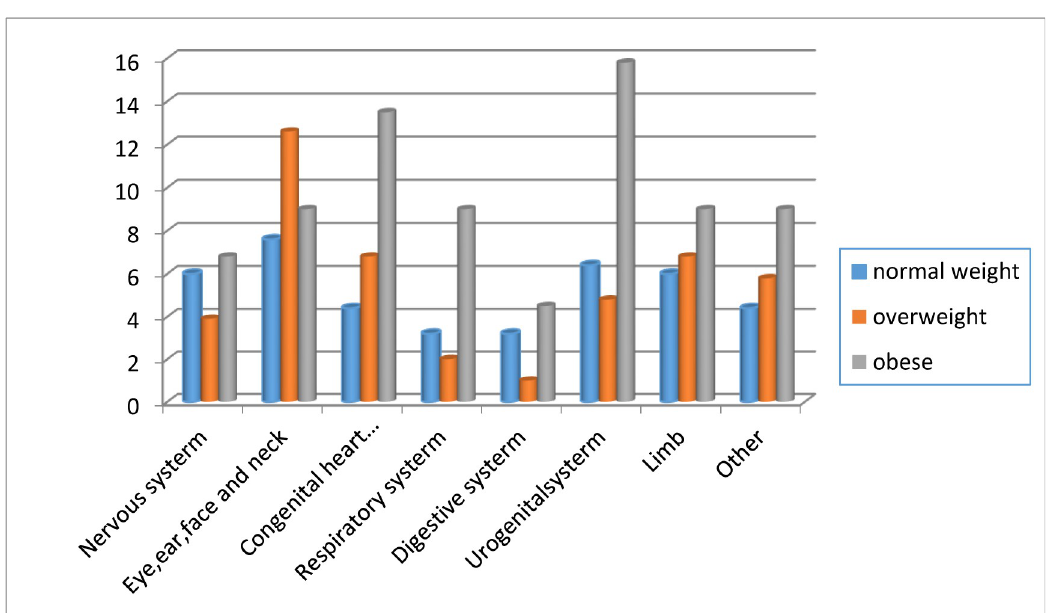
Fig 2. Prevalence of major congenital malformations in live singleton births conceived by IVF.